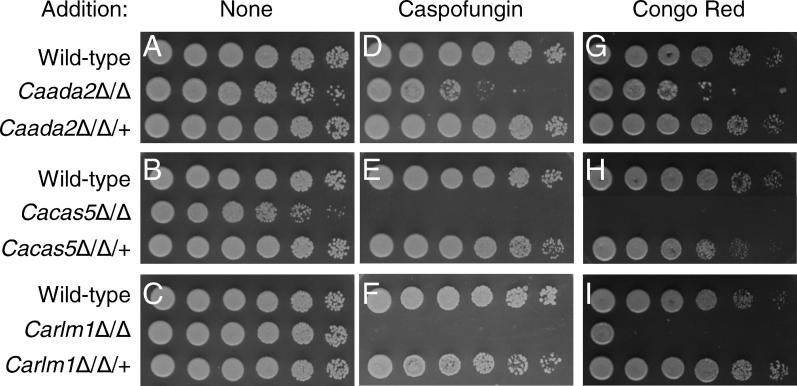
Growth of Wild-Type, Mutant, and Complemented Strains on Caspofungin MediumSerial dilutions of an overnight culture were spotted on YPD medium with no addition (A–C), 25 ng/ml caspofungin (D and E), 125 ng/ml caspofungin (F), or 50 μg/ml Congo red (G–I). Growth was visualized after 1–2 d at 30 °C. The wild-type reference strain (DAY185), mutant (Δ/Δ), and complemented (Δ/Δ/+) strains are shown. All strains were prototrophic; detailed genotypes are listed in Table S2.